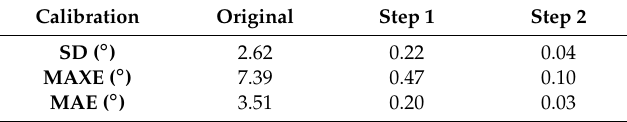
Figure 9. Comparison of AOP error before and after calibration. Table 2. Orientation-angle error comparison.